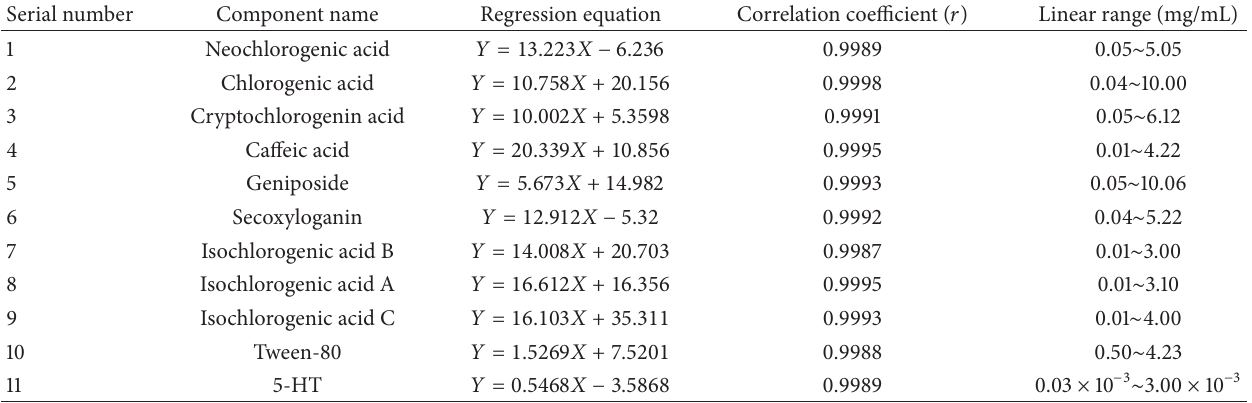
Table 2: Regression equation, linear range, and correlation coefficient of investigated